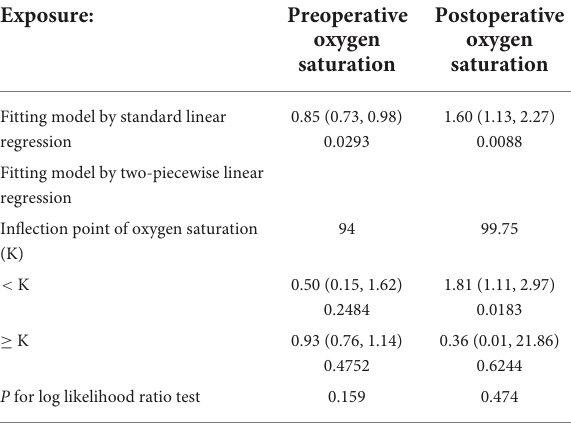
TABLE 3 The results of two-piecewise linear regression